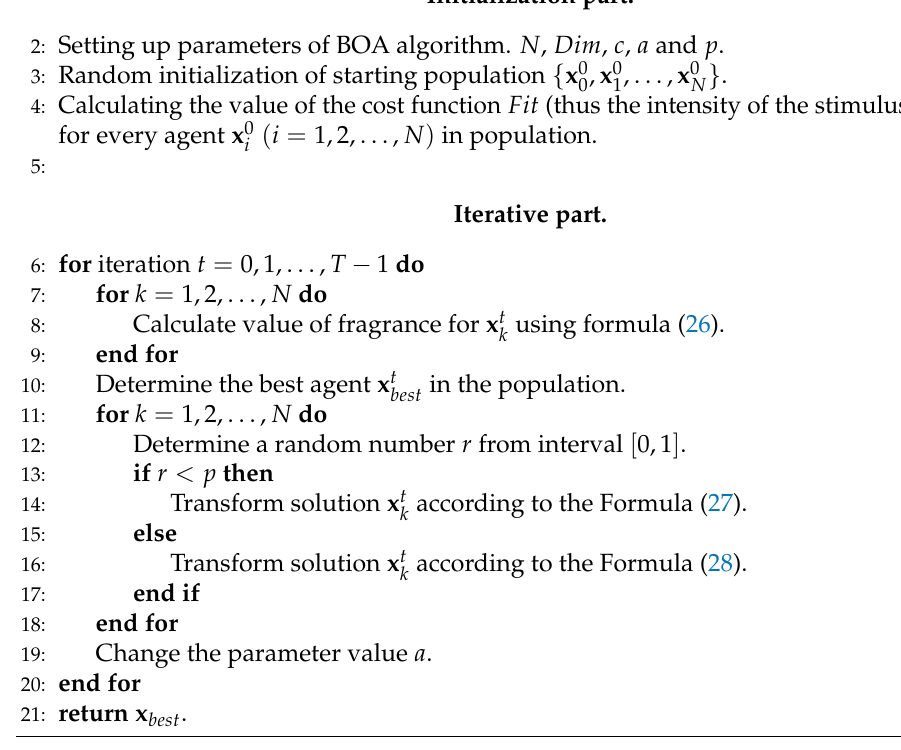
Algorithm 4 Butterfly optimization algorithm (BOA)